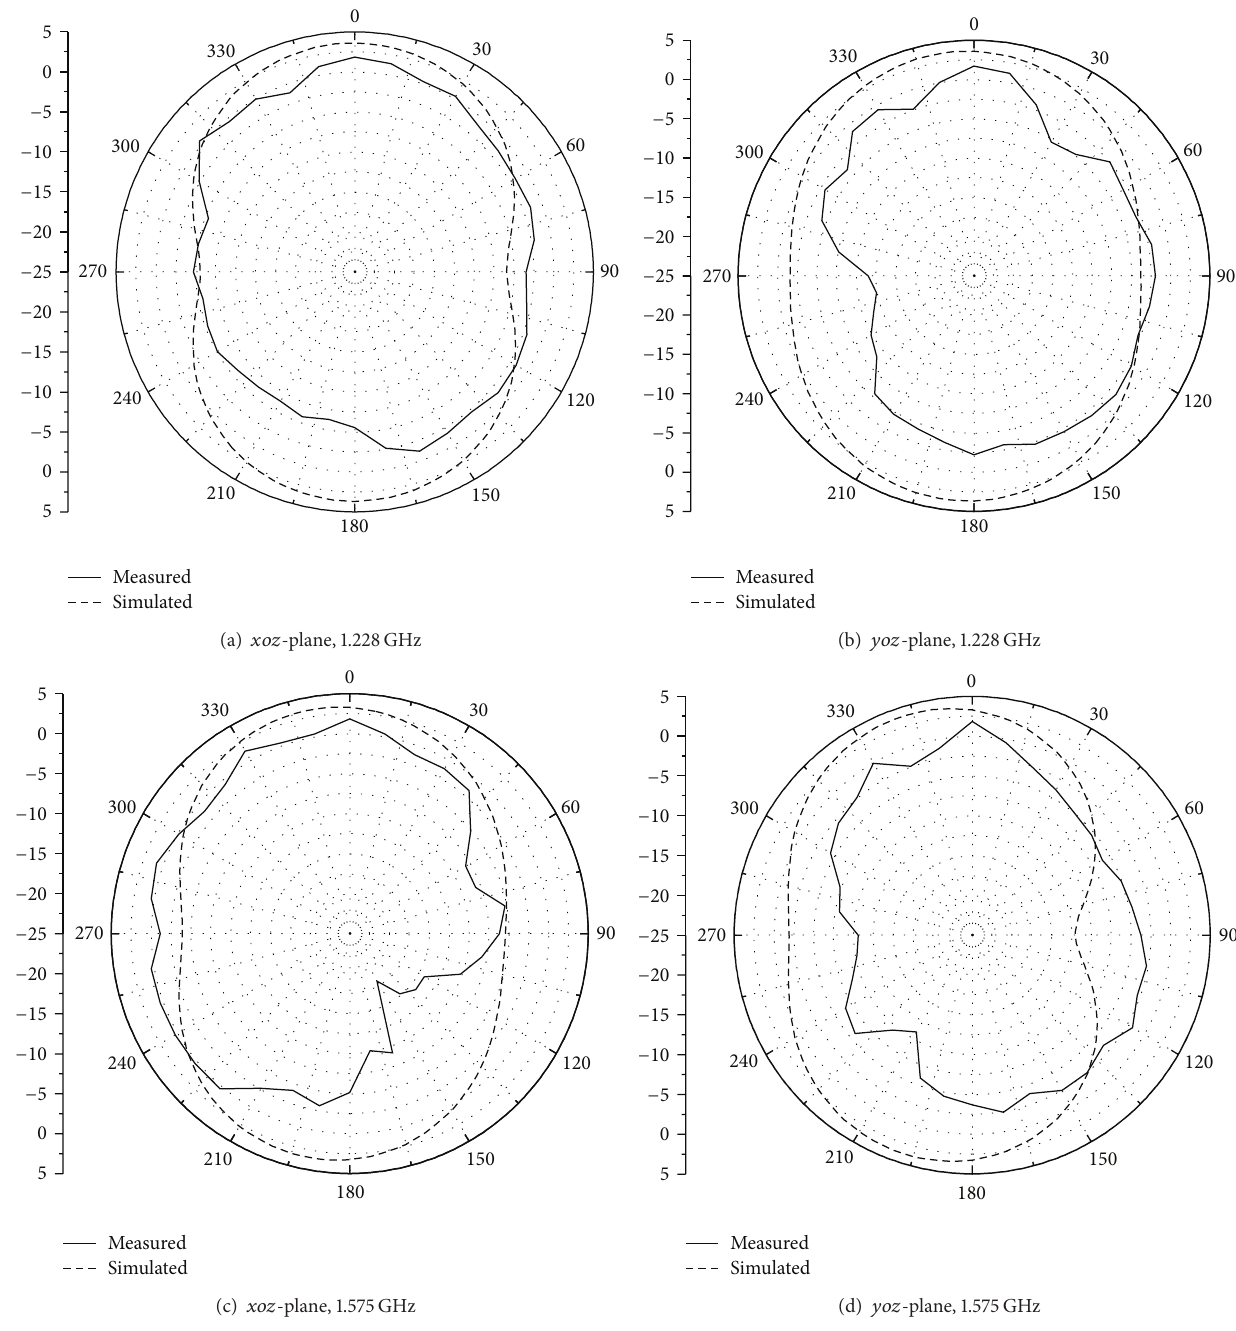
Figure 14: Comparison between measured and simulated results of radiation